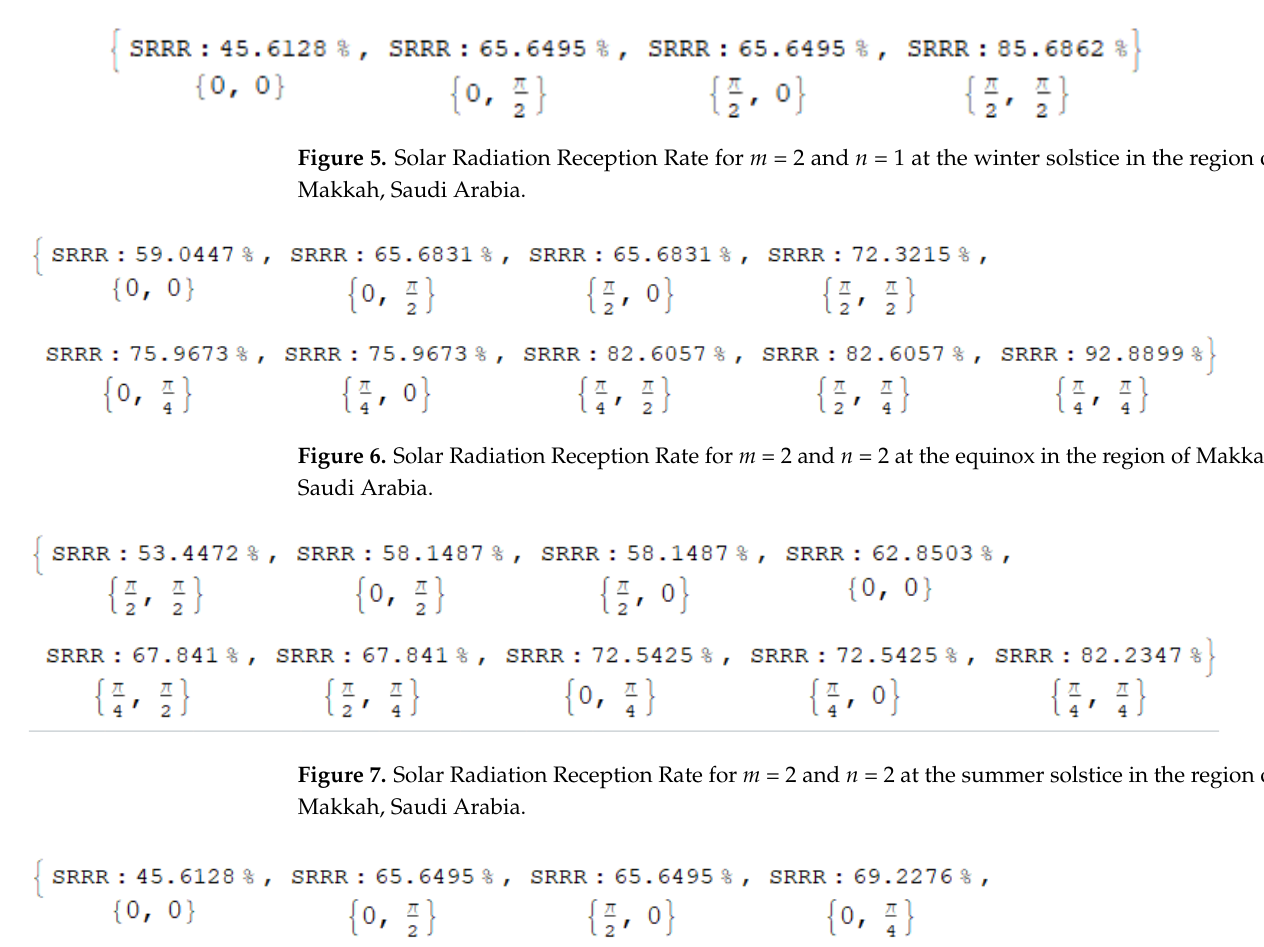
Figure 4. Solar Radiation Reception Rate for m = 2 and n = 1 at the summer solstice in the region of Makkah, Saudi Arabia.